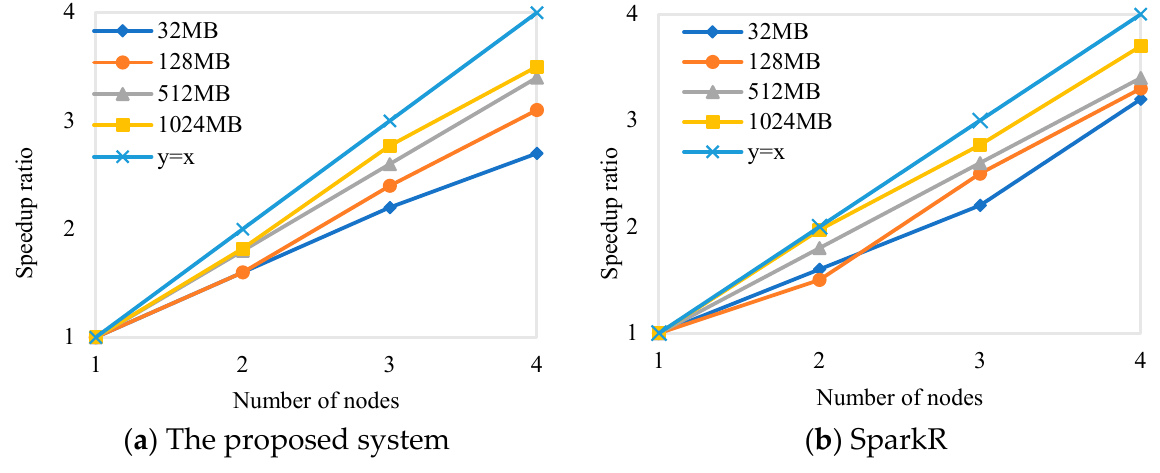
Figure 5. Comparison with regards to speedup.